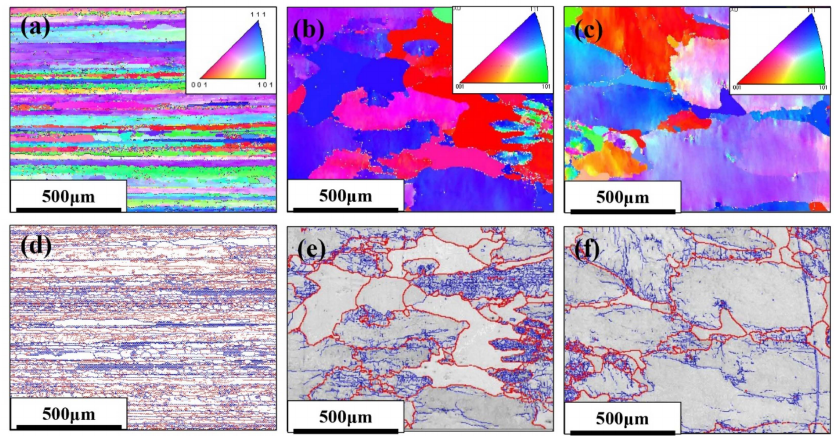
Figure 5. IPF and BC images of the different plates after different solution times: ( a , d ) the 25 mm plate treated for 90 min; ( b , e ) the 65 mm plate treated for 30 min; ( c , f ) the 120 mm plate treated for 90 min.